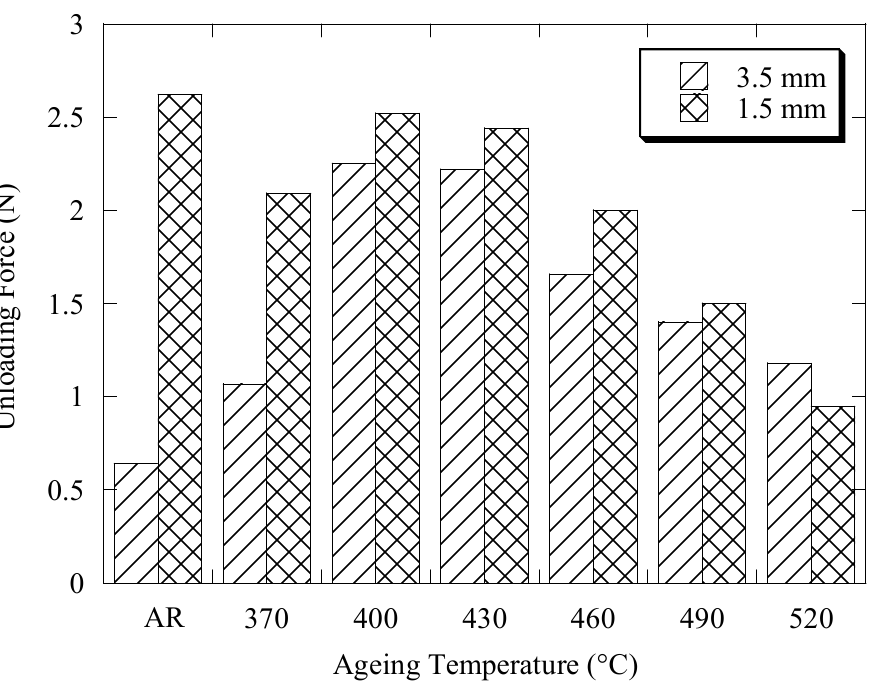
Figure 6. Variation in unloading force exhibited by the as-received and aged NiTi archwires at 3.5 mm and 1.5 mm deflection in the modified three-bracket bending setup.